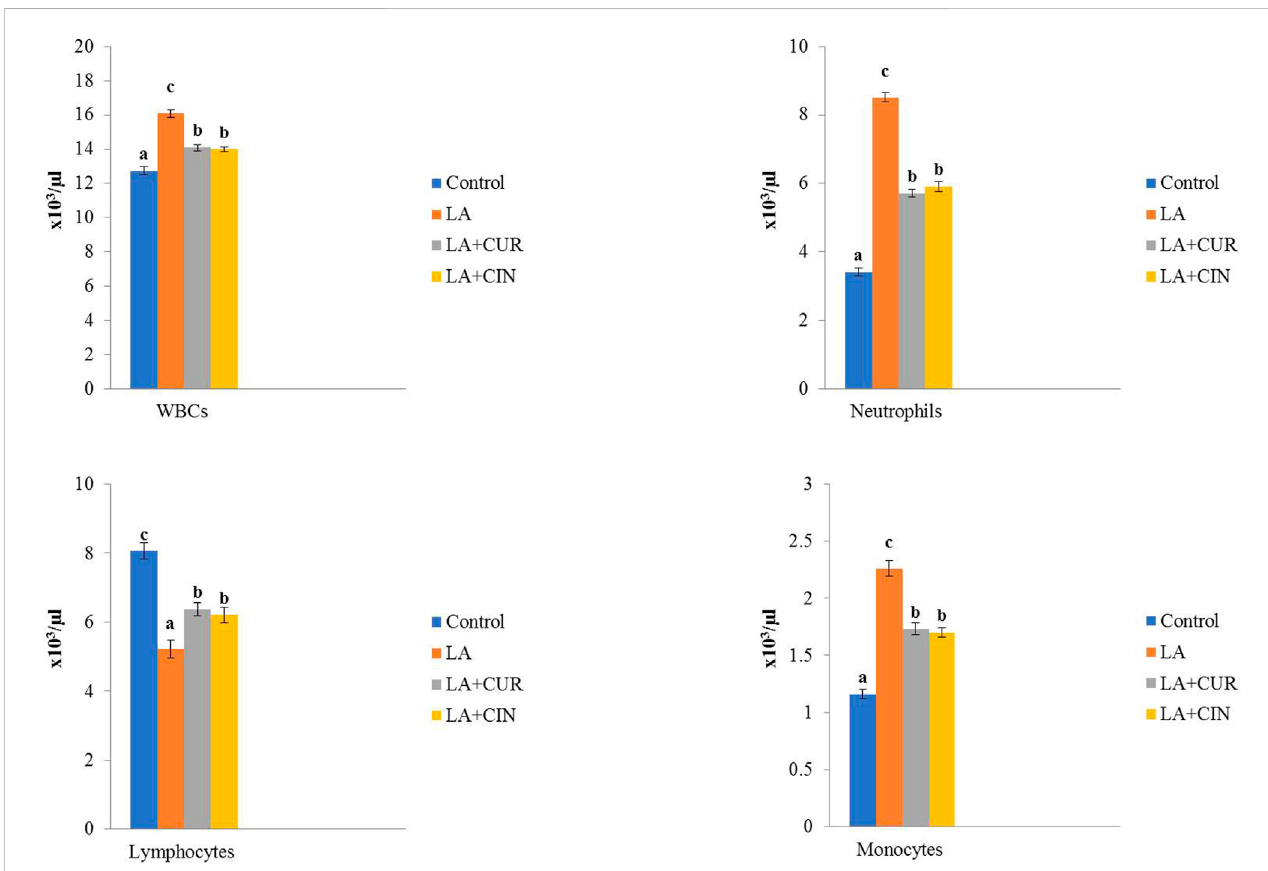
FIGURE 2 Changes ofleukogram indifferenttreatment groups compared to thecontrol (mean ± SE). Different superscript lettersineach fi gure indicate signi fi cant differences at p < .05.